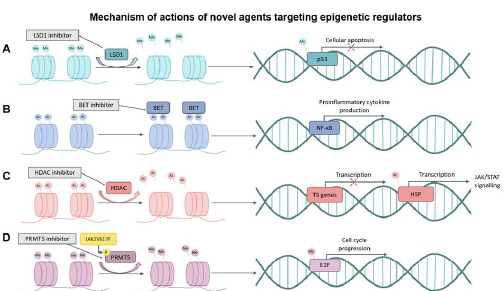
Figure 1. Mechanism of actions of novel agents targeting epigenetic regulators. (A) Removal of methyl groups by LSD1, inhibiting p53 methylation and abrogating cellular apoptosis. LSD1 in- hibitor antagonizes LSD1 to restore tumor-suppressive effects of p53. (B) Anchoring of BET pro- teins to acetylated lysine residues to activate NF- κB pathway. BET inhibitors block BET proteins and the proinflammatory pathway to reduce synthesis of proinflammatory cytokines. (C) Removal of acetyl groups by HDAC, decreasing tumor-suppressor gene transcription while deacetylating HSP to aggravate JAK/STAT signaling pathway. This effect can be overcome by HDAC inhibitors. (D) Aberrant phosphorylation of PRMT5 by JAK2V617F, leading to impaired methylation activity. Thus, E2F is methylation for cell cycle progression and myeloproliferation. The aberrant activation